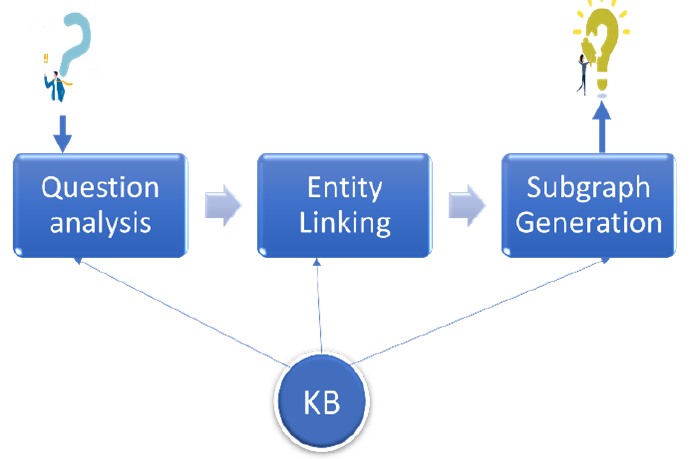
Figure 19. Subgraph-Based Architecture.